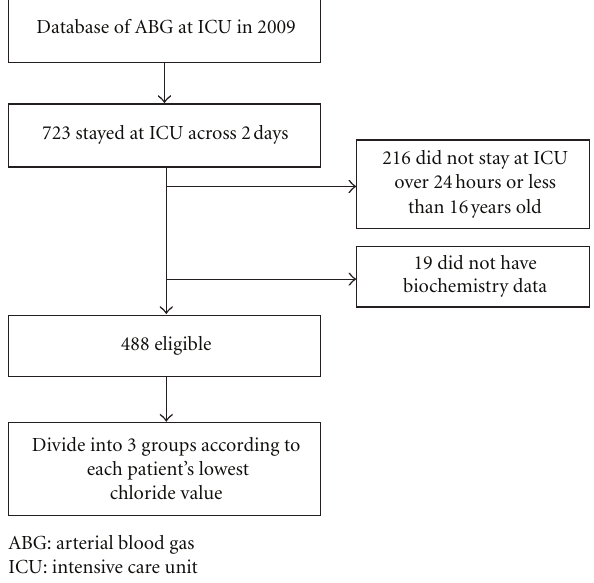
Figure 1: Flow diagram of patients selection during the